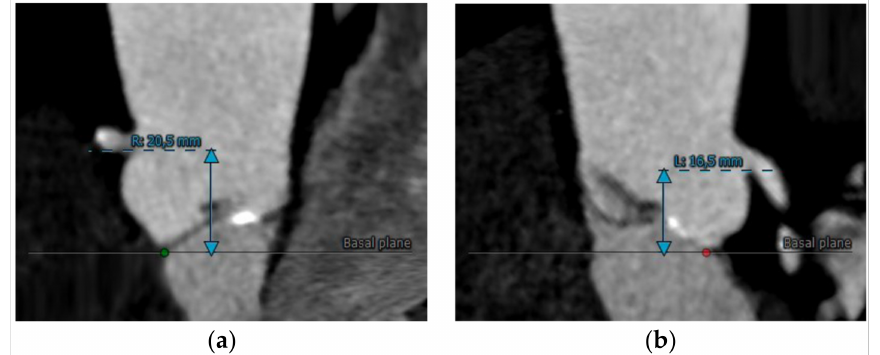
Figure 6. ( a ) Right and ( b ) left coronary ostia height assessment by CT